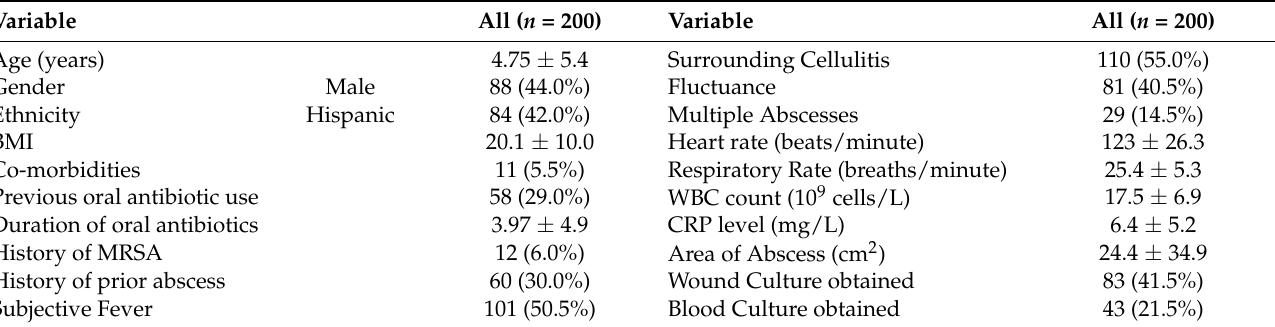
Table 1. Demographics and patient